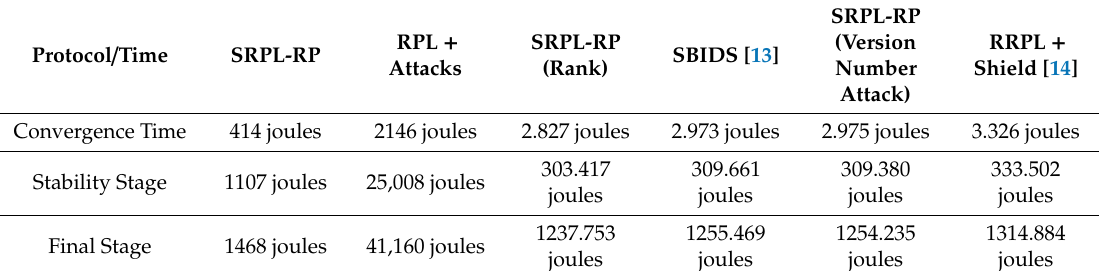
Table 10. Average Energy Consumption Comparison in Grid-Random Topology.